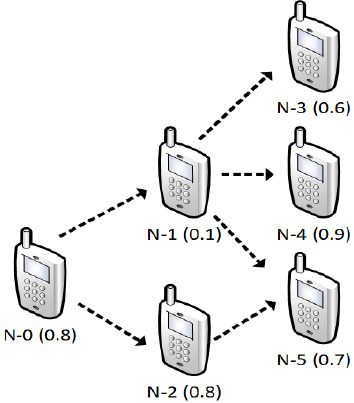
Figure 8. QGR interaction and routing scenario [38].